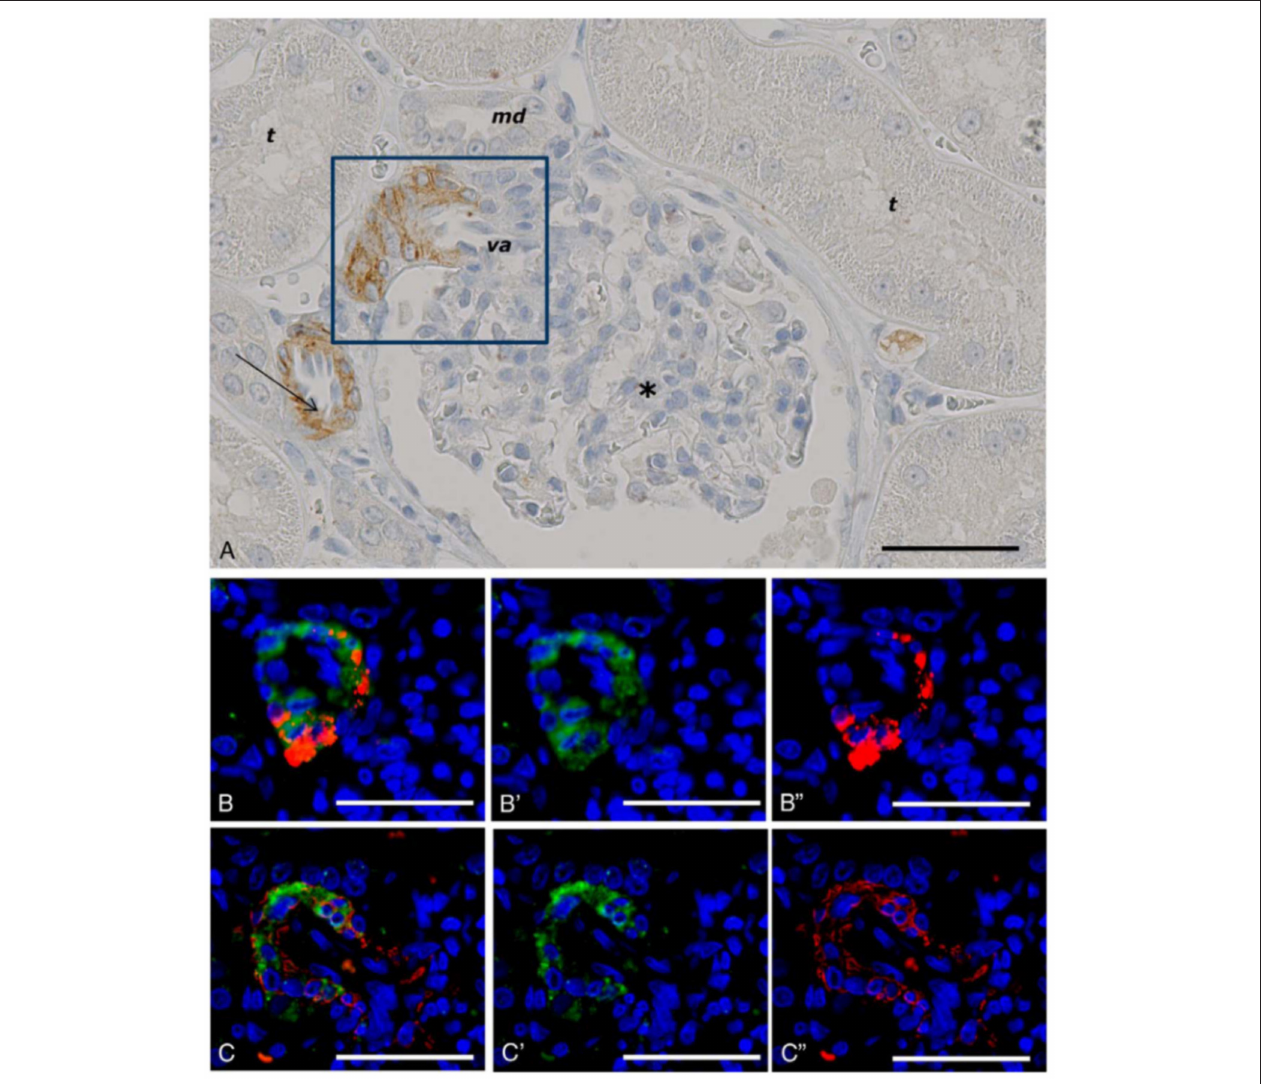
FIGURE 6 | GLP-1 receptor immunoreactivity in non-human primate smooth muscle cells. (A) GLP-1R immunoreactivity in non-human primate smooth muscle cells of a vas afferens (va) arteriole at the vascular pole. Note the absence of signal in the macula densa (md), tubuli (t), glomerulus (*), and endothelial cells within an arteriole (arrow). (B,C) Near-adjacent sections showing double labeling for GLP-1R (green)/renin (red) and GLP-1R (green)/SMA (red), respectively. (B ′ ,C ′ ) Same as (B,C) , respectively, with red fluorescence digitally removed to highlight GLP-1R immunoreactivity. (B ′′ ,C ′′ ) Same as (B,C) , respectively, with green fluorescence digitally removed to highlight renin and SMA immunoreactivity, respectively. Scale bars correspond to 50 µ m.GLP-1R, glucagon-like peptide 1 receptor; SMA, smooth muscle actin. Reproduced with permission from Pyke et al. (73). By permission of Oxford University Press on behalf of the Endocrine Society, available at: https:// academic.oup.com/endo/article/155/4/1280/2423090?searchresult=1. This figure is not included under the CC-BY license of this publication. For permissions, please contact